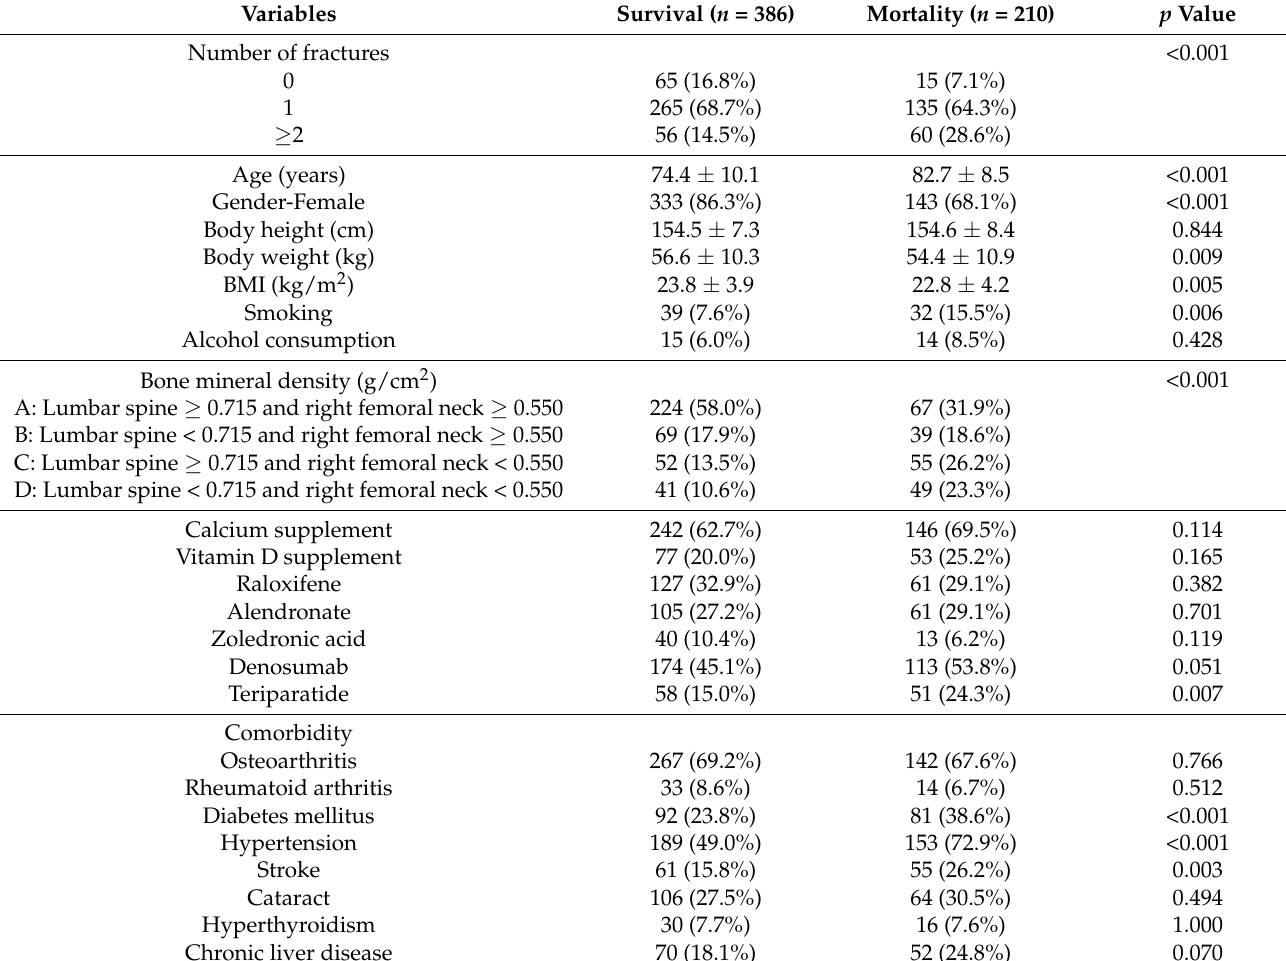
Table 2. Comparisons of demographic data of participants by survival